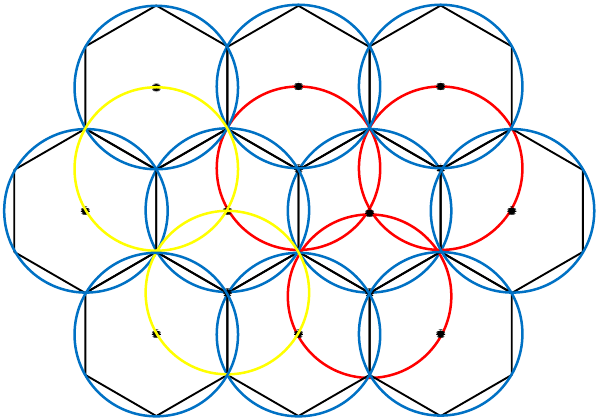
Figure 3. A schematic diagram of a 2-fold coverage-based node deployment strategy in a cellular network.